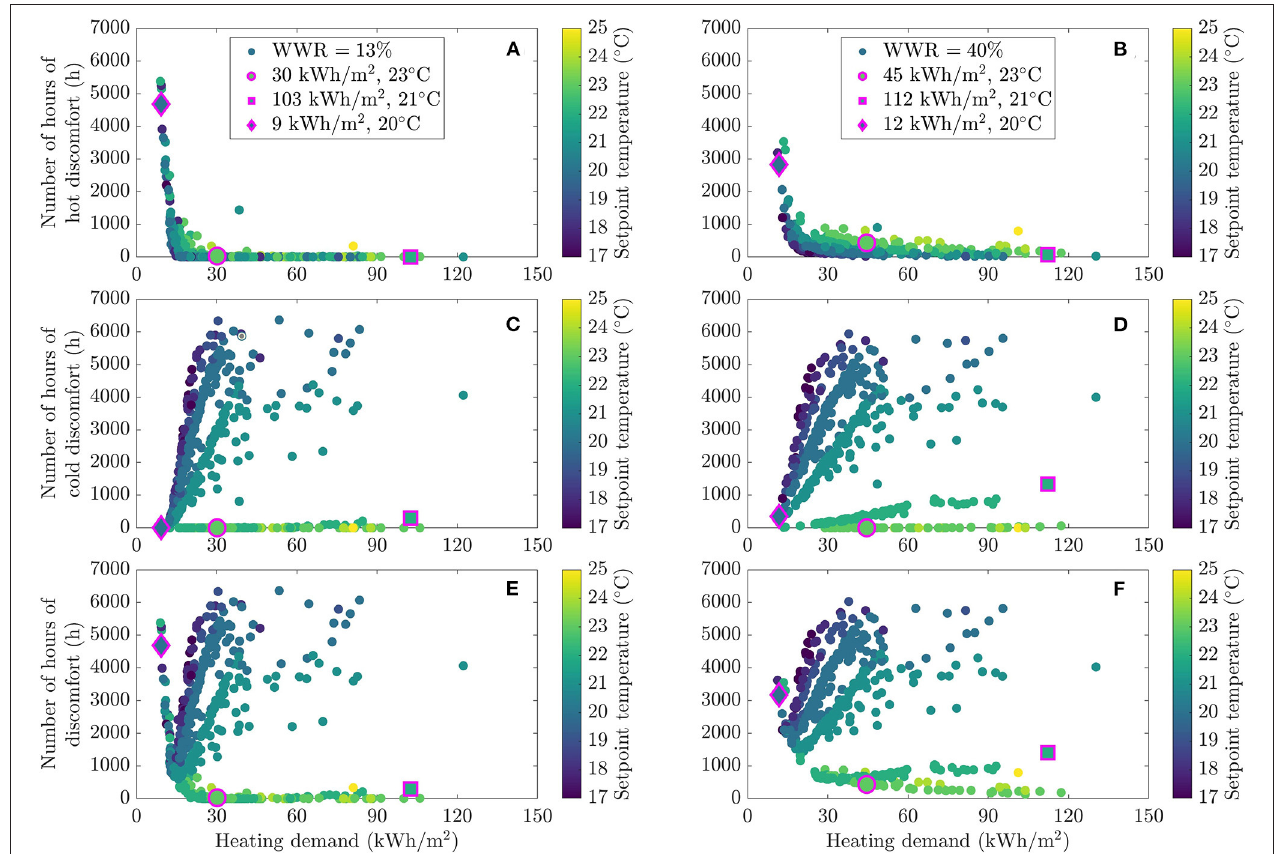
FIGURE 7 | Energy and comfort performance in the dwelling for different occupant profiles, colored by heating setpoint temperature, reporting on hot discomfort (A,B) , cold discomfort (C,D) , and total discomfort (E,F) as a function of heating demand for two WWR values (13% on the left and 40% on the